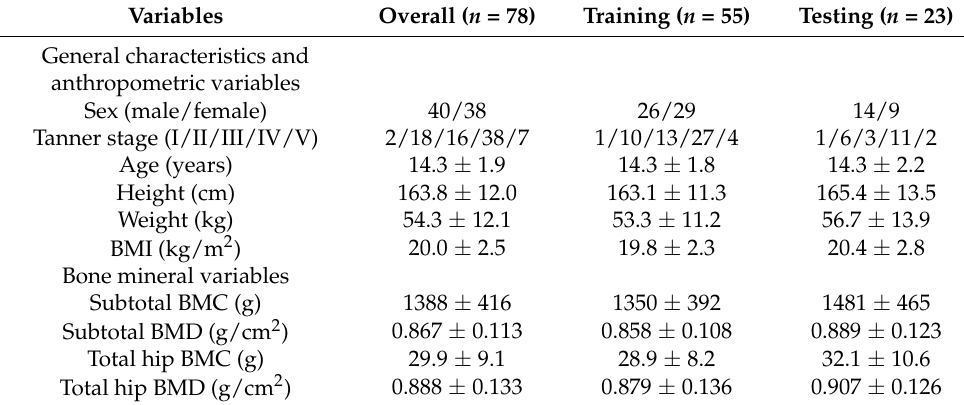
Table 1. Descriptive characteristics of the